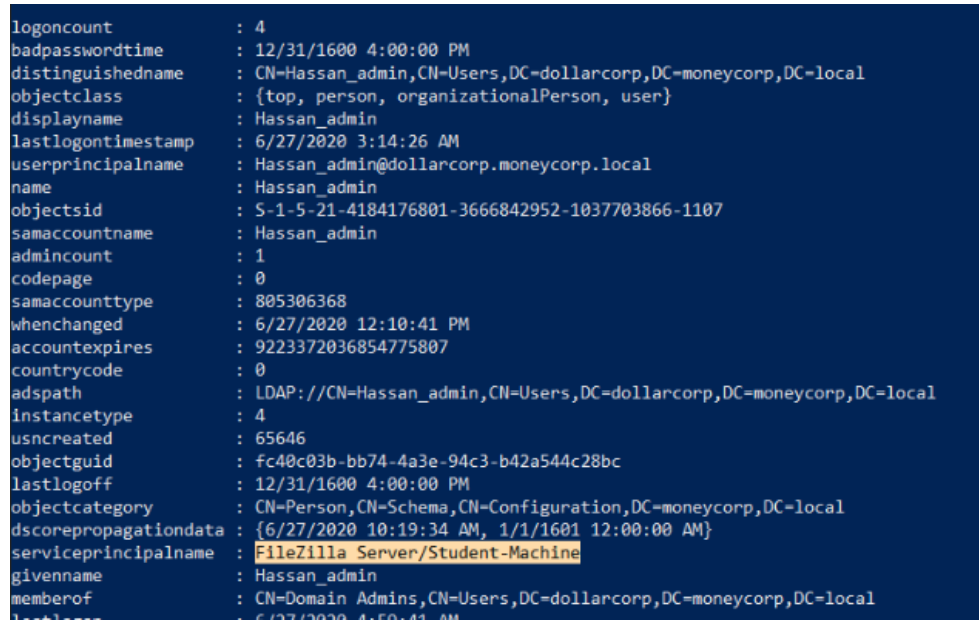
Figure 13. Admin Account has SPN